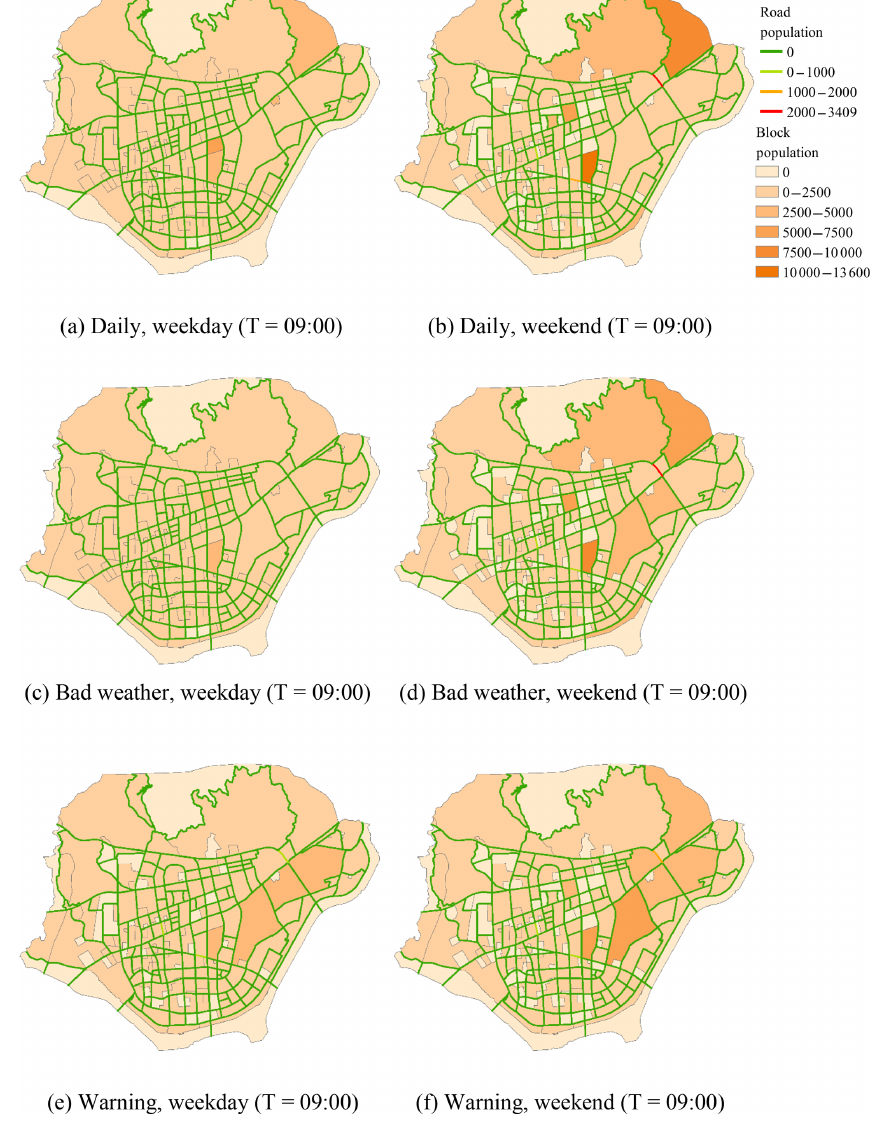
Figure 13. Population distribution for the six scenarios. T means time